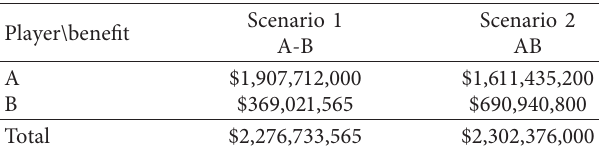
Table 4: Benefits obtained ($COP) by the players in each of the scenarios.